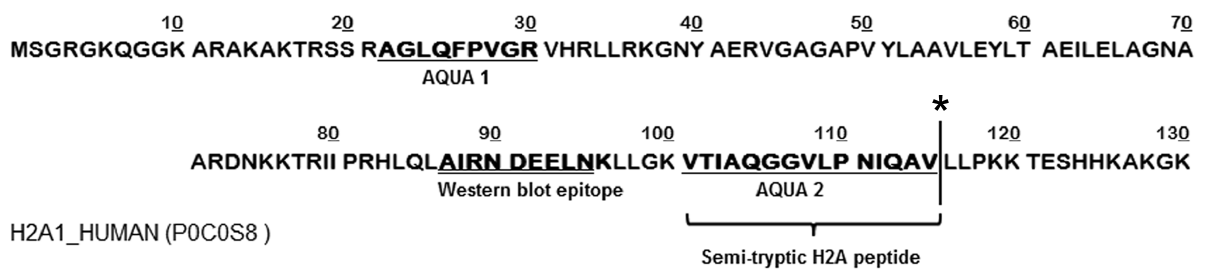
Figure 1. Sequence of histone H2A. Sequence from Uniprot [25]. The VTIAQGGVLPNIQAV peptide ( m / z 740.4, charge 2+) was the only semi-tryptic peptide identified in all six runs. (here described as amino acid 115 since methionine, * indicates the clipping site after V 114 generated by the start codon, is the first amino acid in the Uniprot sequence); Bold underlined sequences are the same as the isotopically labeled absolute quantification (AQUA) peptides, used for the subsequent specific cH2A quantitation. The bold double underlined sequence is the Western blot